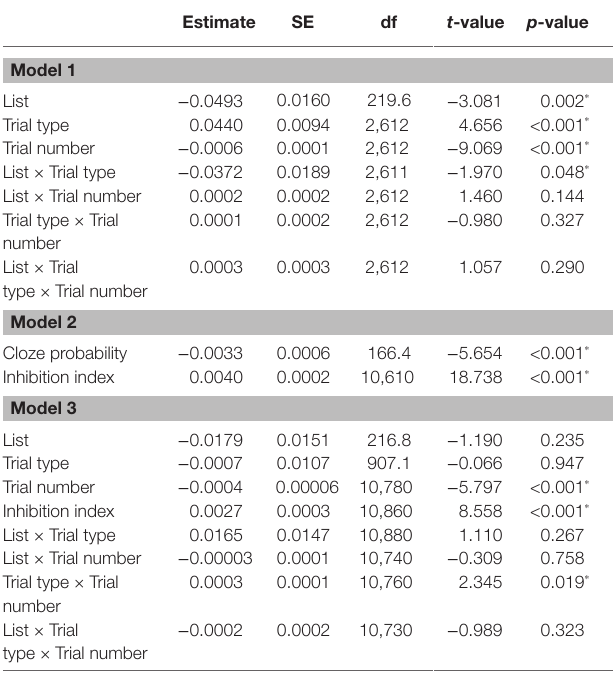
TABLE 3 | Mixed-effects regression models coefficients for Experiment 1.